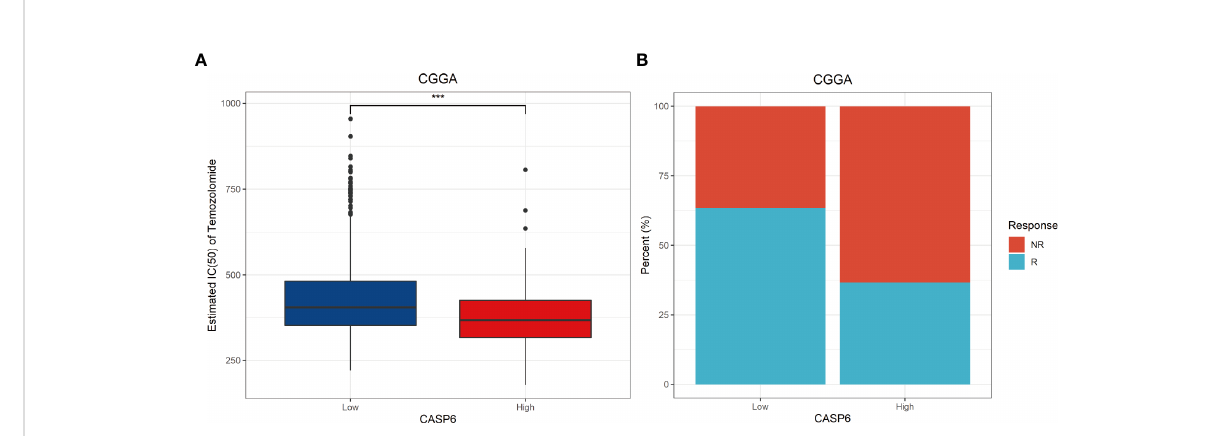
FIGURE 6 Potential predictive value of CASP6 in chemotherapy and immunotherapy in the CGGA database. (A) IC50 of temozolomide in the low and high CASP6 expression groups. Low CASP6 expression group (n = 326), high CASP6 expression group (n = 325) (B) Immunotherapy responses in the low and high CASP6 expression groups. Low CASP6 expression group [response: n = 207, (63.50%); non-response: n = 119, (36.50%)], high CASP6 expression group (response: n = 119, (36.62%); non-response: n = 206, (63.38%)) *** P <